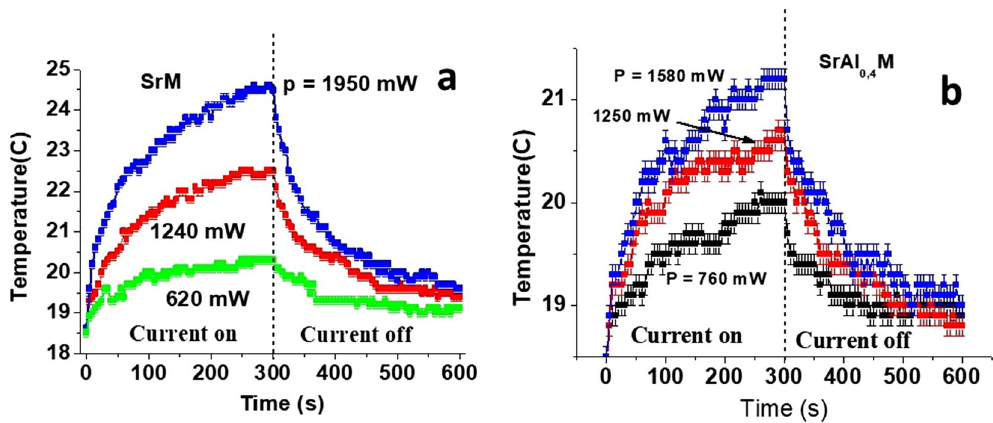
Figure 7. Time dependence of the sample temperature when a DC power is applied to platelets of ( a ) SrFe 12 O 19 and ( b ) SrAl 0.4 Fe 11.6 O 19 . Data are for a time interval of 300 s when the power turned on and then turned